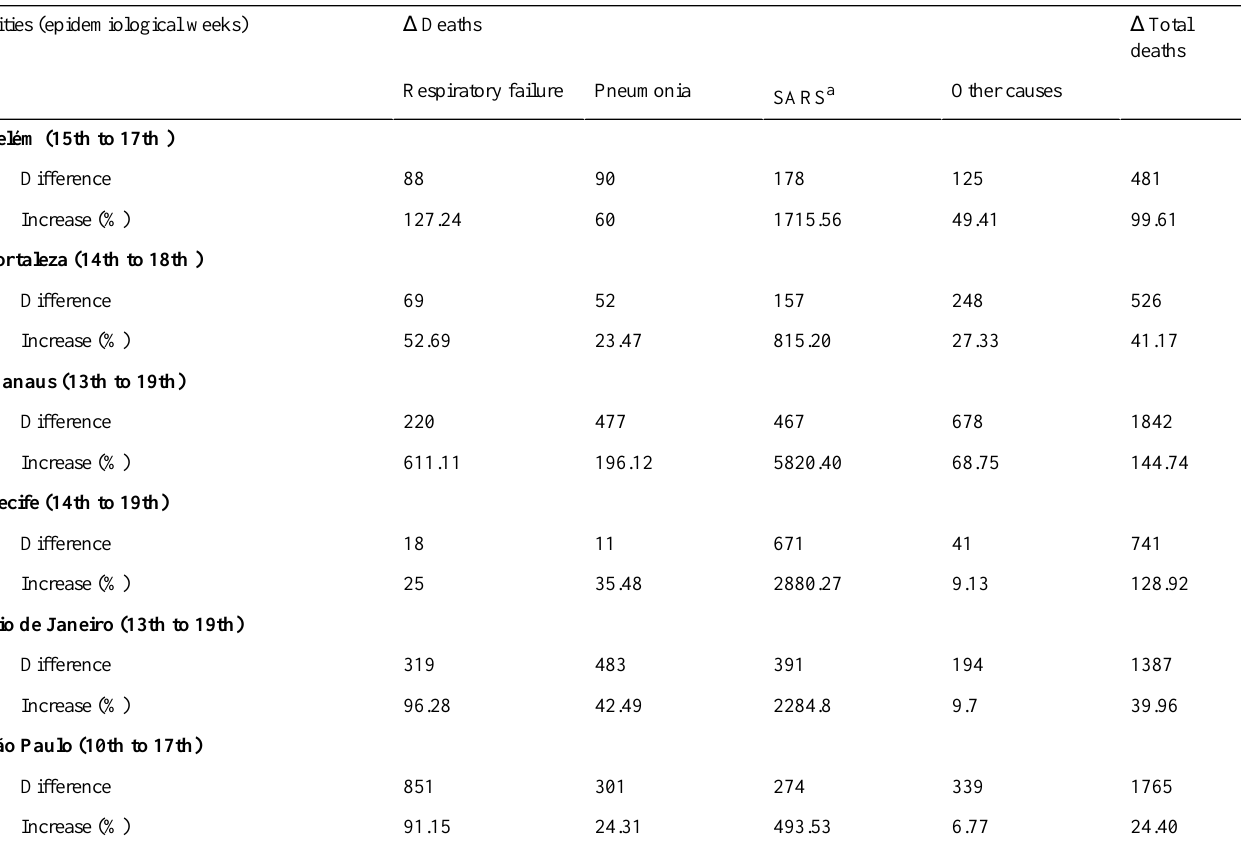
Table 5. Difference ( ∆ ) between real and predicted values.